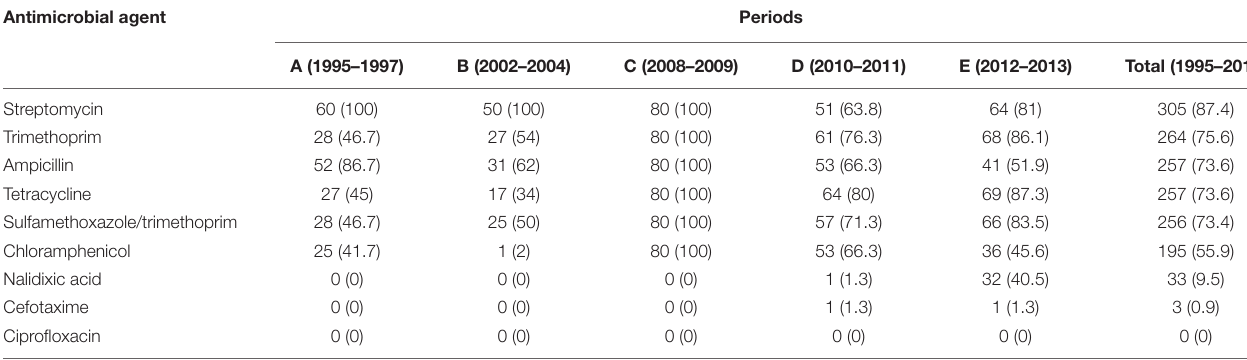
TABLE 1 | Antimicrobial resistance of Chilean Shigella sonnei strains from 1995 to 2013. Antimicrobial agent Periods